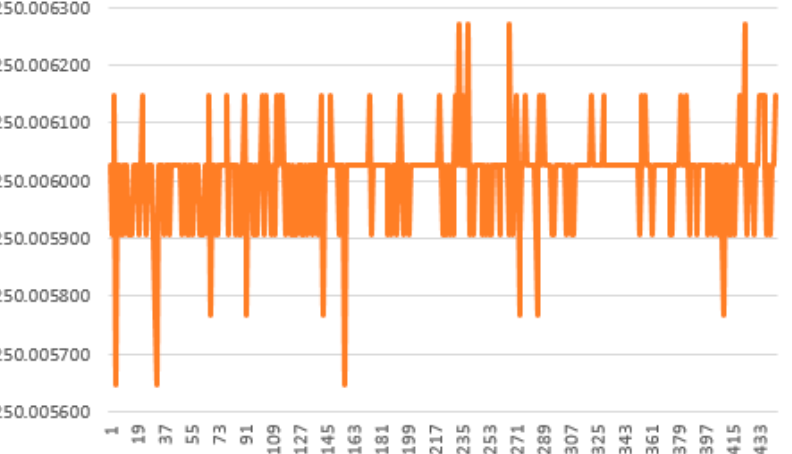
Figure 7. Measured ratios Fr / Fx for 4000 periods of Fx derived from the 24 MHz crystal oscillator (100 ms delay between consecutive measurements).